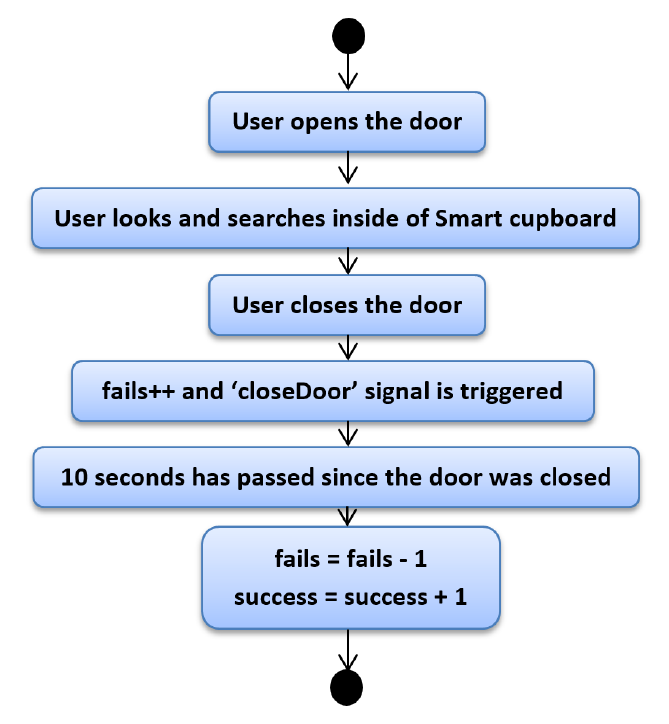
Figure 4. Python script—First